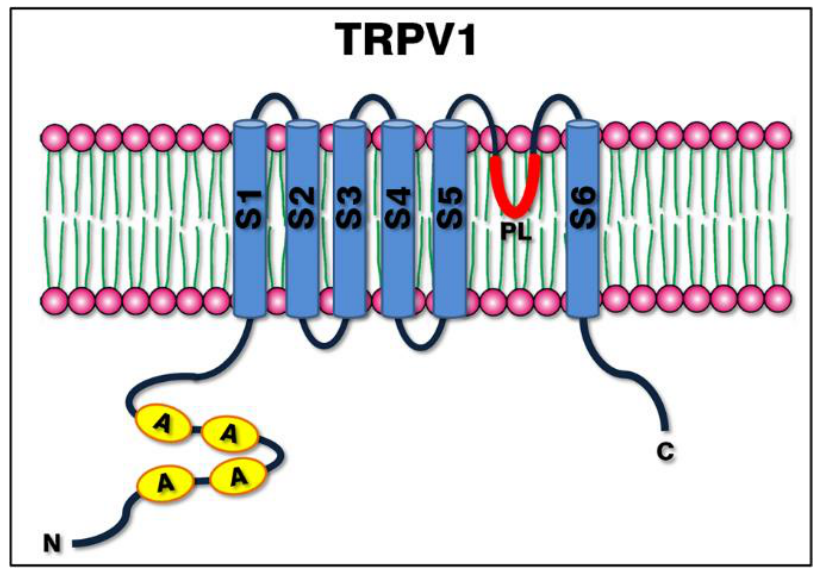
Figure 2. Structure of the TRPV1 channel. The image shows a simplified schema of the protein structure within the plasma membrane, consisting of six transmembrane helices (S1 to S6), a hy- drophobic pore loop (PL) between S5 and S6, the N-terminal domain rich in ankyrin repeats and the C-terminal